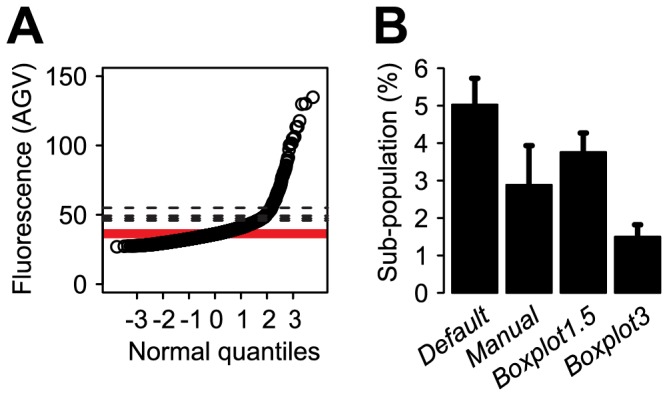
Example of a data set showing poorer Q-Q plot performance (smooth curve of distributed data points).(A) Q-Q plot of single cell eGFP fluorescence values obtained from P. putida UWC1-ICEclc Pint-egfp cells (strain 2508) grown on 3CBA to early stationary phase. Width of the red line corresponds the interquartile range of the fluorescence values. Dotted lines indicate threshold line placement for subpopulation calculation via methods Boxplot3, Boxplot1.5, Default and Manual. (B) Results from the four different subroutines on this data set. Error bars represent 95% confidence intervals on re-sampled data sets with bootstrapping (see Figure 4).